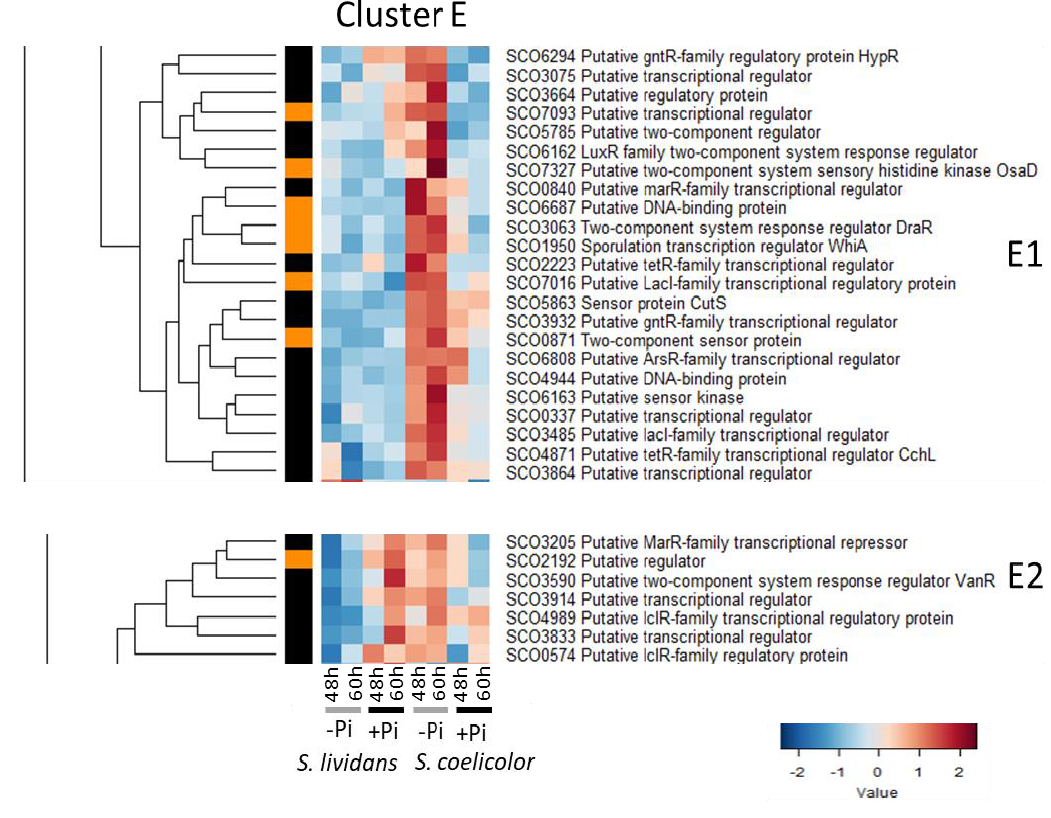
Figure 6. Cluster E, heatmap representation of transcriptional regulators and sensory histidine kinases more abundant in Pi limitation than in Pi proficiency in SC . Cluster E can be divided into 2 sub-clusters, E1 and E2. The 23 regulators of sub-cluster E1 were more abundant in Pi limitation than in Pi proficiency in SC but not in SL . The 7 regulators of sub-cluster E2 were more abundant in Pi limitation than in Pi proficiency in SC but were also abundant at 60 h in Pi proficiency in SL .